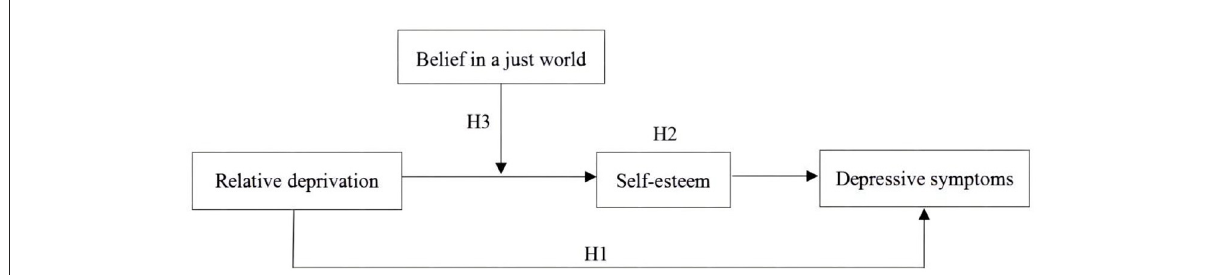
FIGURE1 Moderated mediation model of the present study. Of these, H1 refers to that relative deprivation is positively associated with depressive symptoms. H2 represents that self-esteem mediate the association between relative deprivation and depressive symptoms. H3 refers to that belief in a just world moderate the relation between relative deprivation and